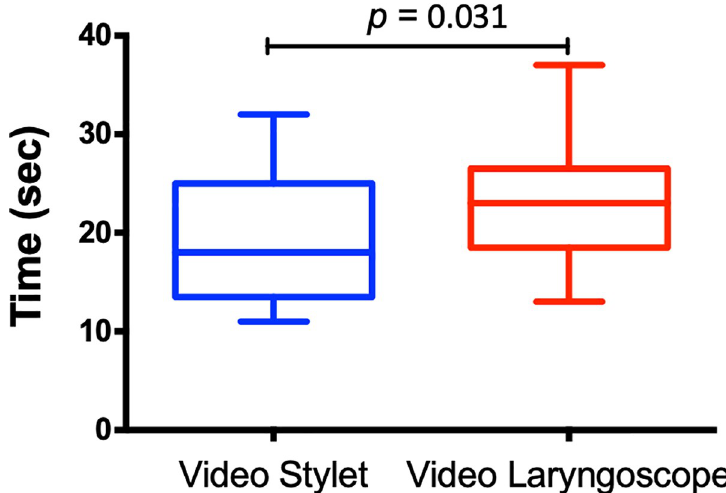
Fig 1. Total time to intubation in a simulated difficult airway ( n = 21). Boxes span the interquartile range; the line within each box denotes the median, and whiskers indicate the minimum and maximum values.